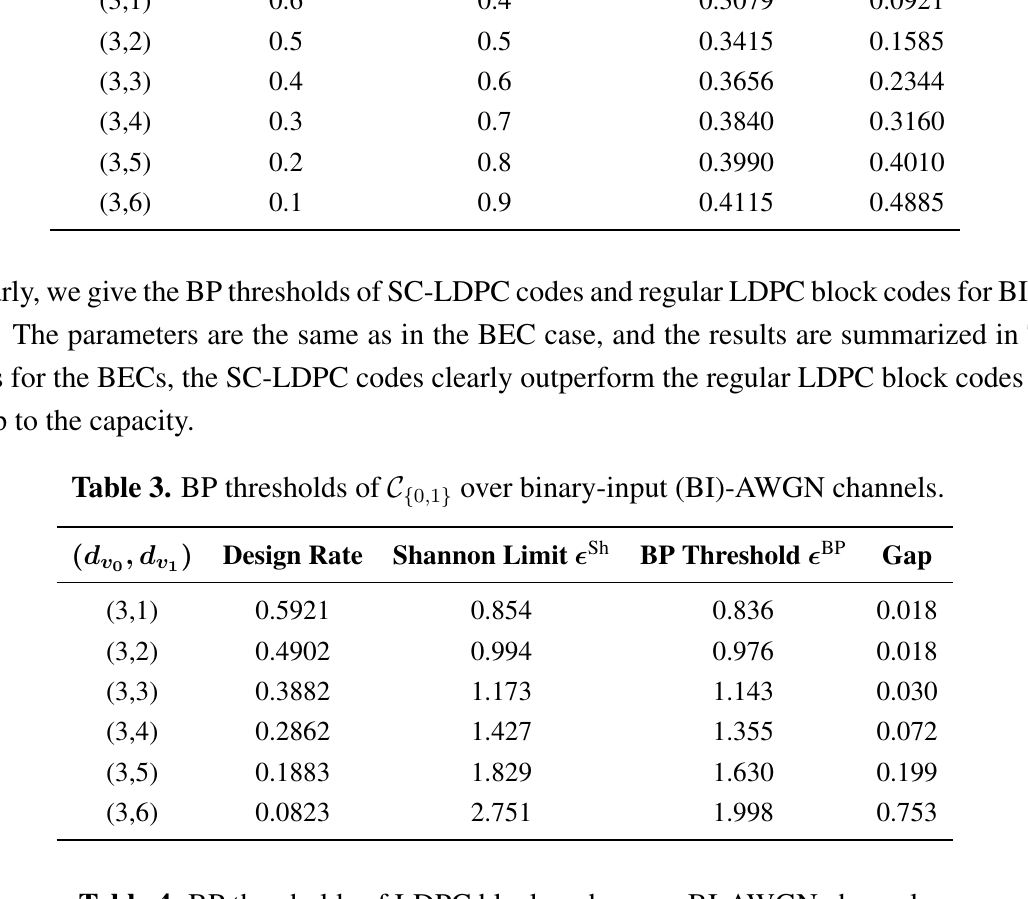
Table 4. BP thresholds of LDPC block codes over BI-AWGN